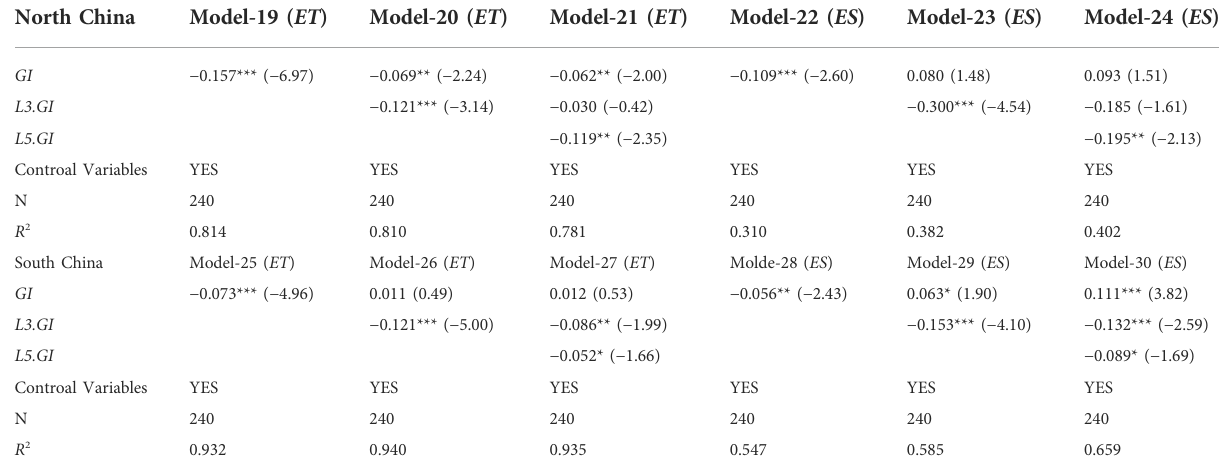
TABLE 5 Results of regional differentiation